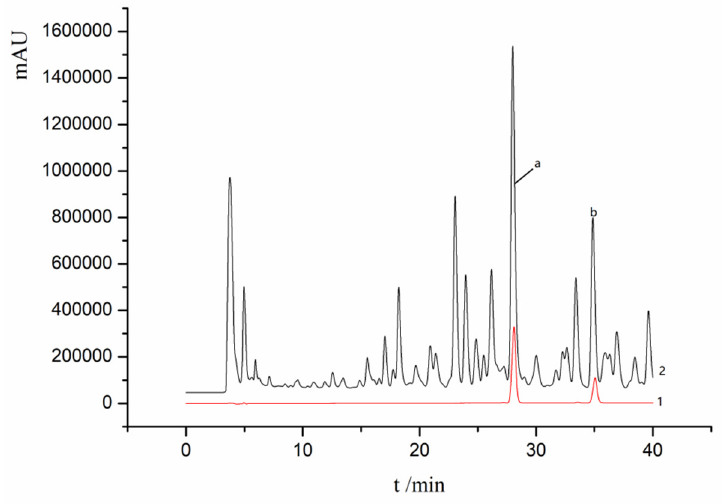
Figure 12. HPLC chromatograms of the standard solution (1) and the test sample solution (2): (a) Ganoderic acid A, (b) Ganoderic acid D.